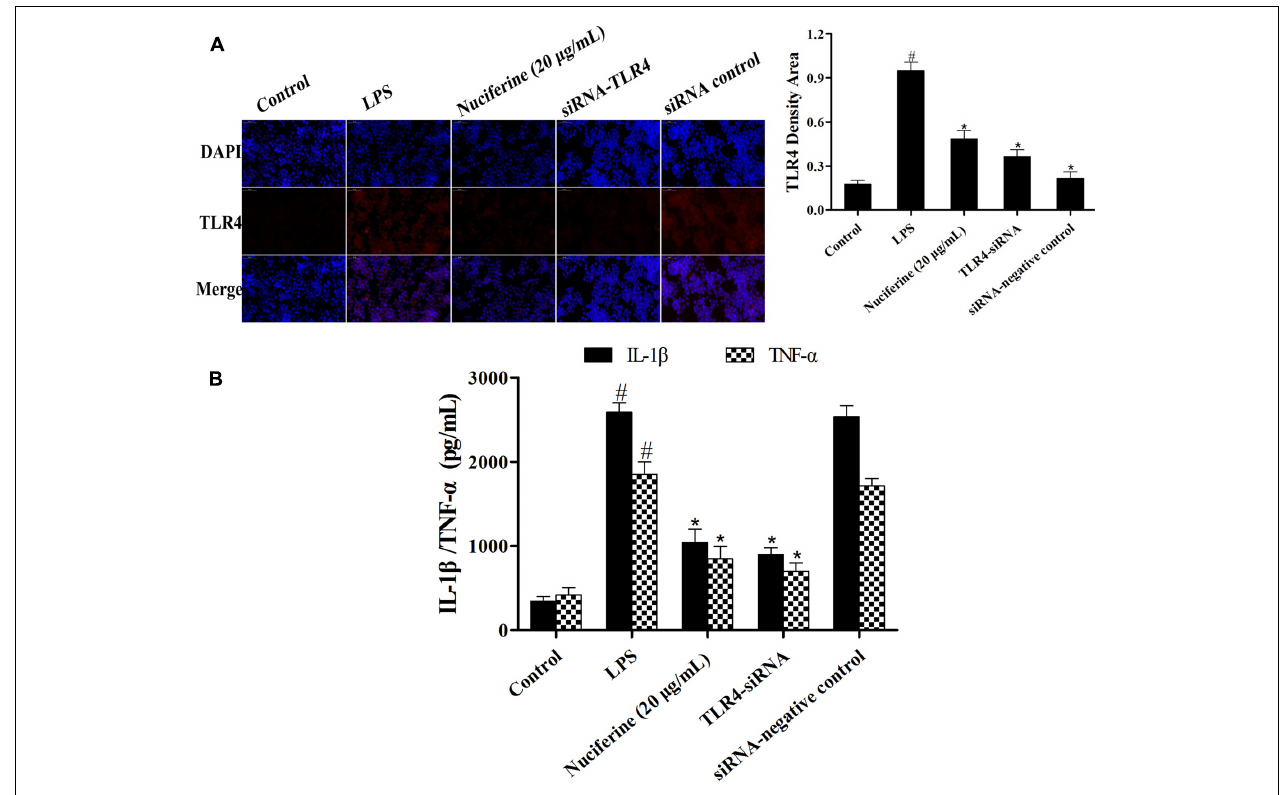
FIGURE 7 | Effects of TLR4-siRNA transfection on LPS-induced inflammatory responses. (A) RAW264.7 cells were subjected to transfection with either control siRNA or TLR4 siRNA. The immunofluorescence technique was performed to determine TLR4 expression. Quantification of TLR4 positive density in each group. (B) After TLR4 interference, the LPS induced the production of pro-inflammatory cytokines IL-1 β and TNF- α , which were measured using an ELISA kit. Data are represented as the mean ± SEM of three independent experiments. # p < 0.05 vs. Control group, ∗ p < 0.05 vs. LPS